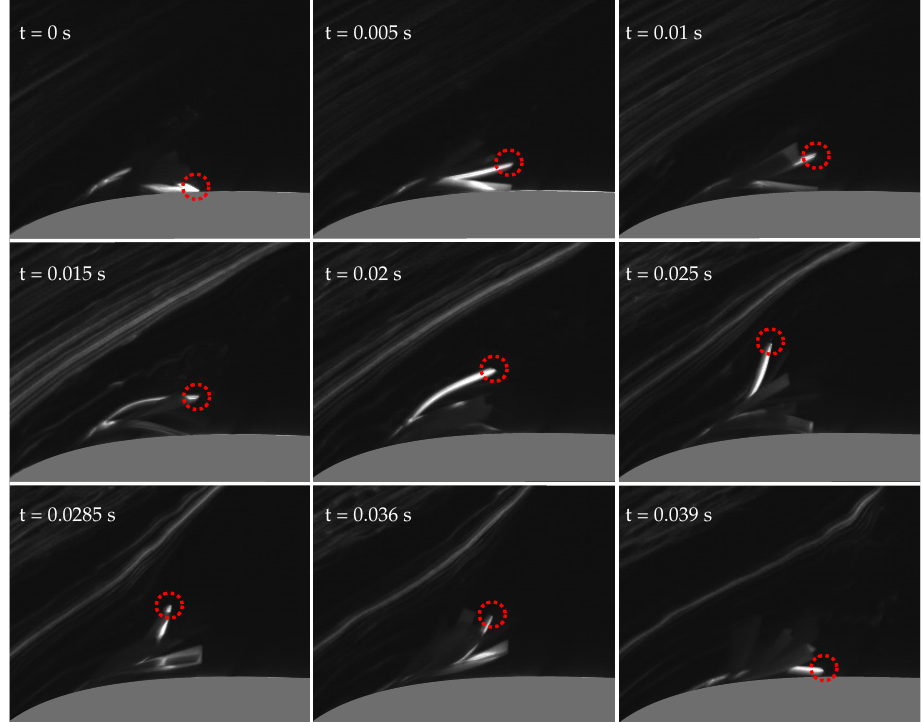
Figure 11. Snapshot of the motion of the leading-edge flaps for one cycle, which includes one up-and-down movement from and towards the airfoil surface (LETE configuration at